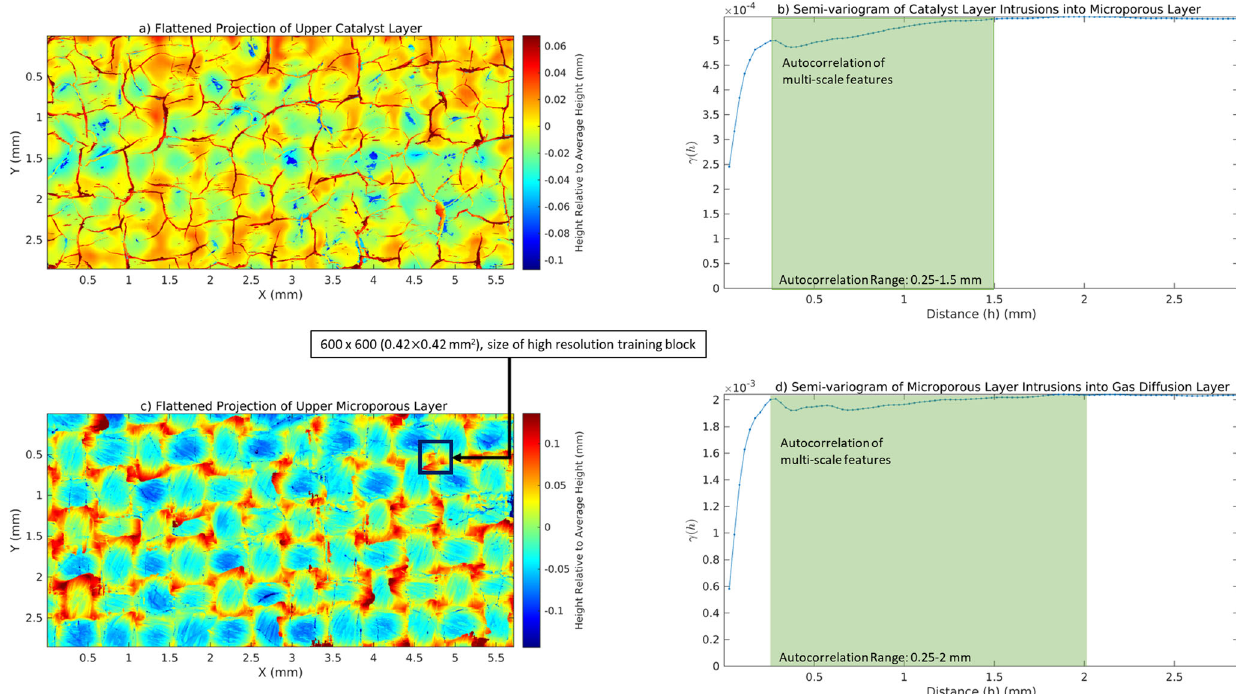
Fig. 3 | Spatial analysis of the super-resolved, multi-label segmented image. a 2D projections of the catalyst layer intrusions into the MPL fractures and b semi- variogram withtypicallengthbetween intrusions of up to 1.5mm. c 2D projections